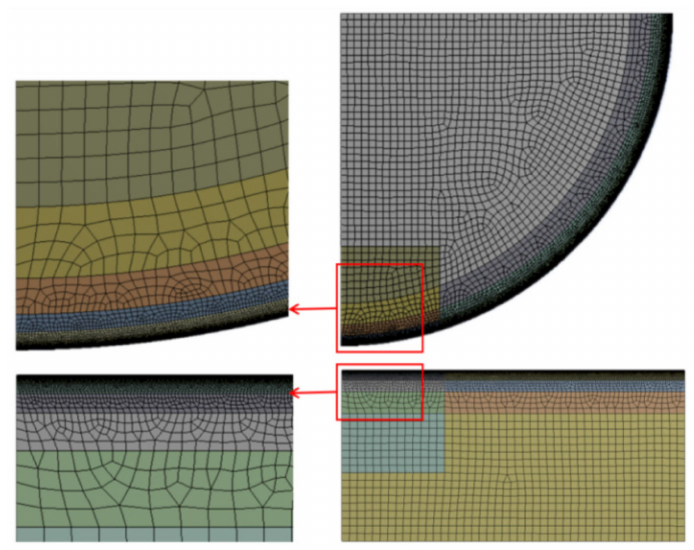
Figure 3. Mesh of the computational domain.